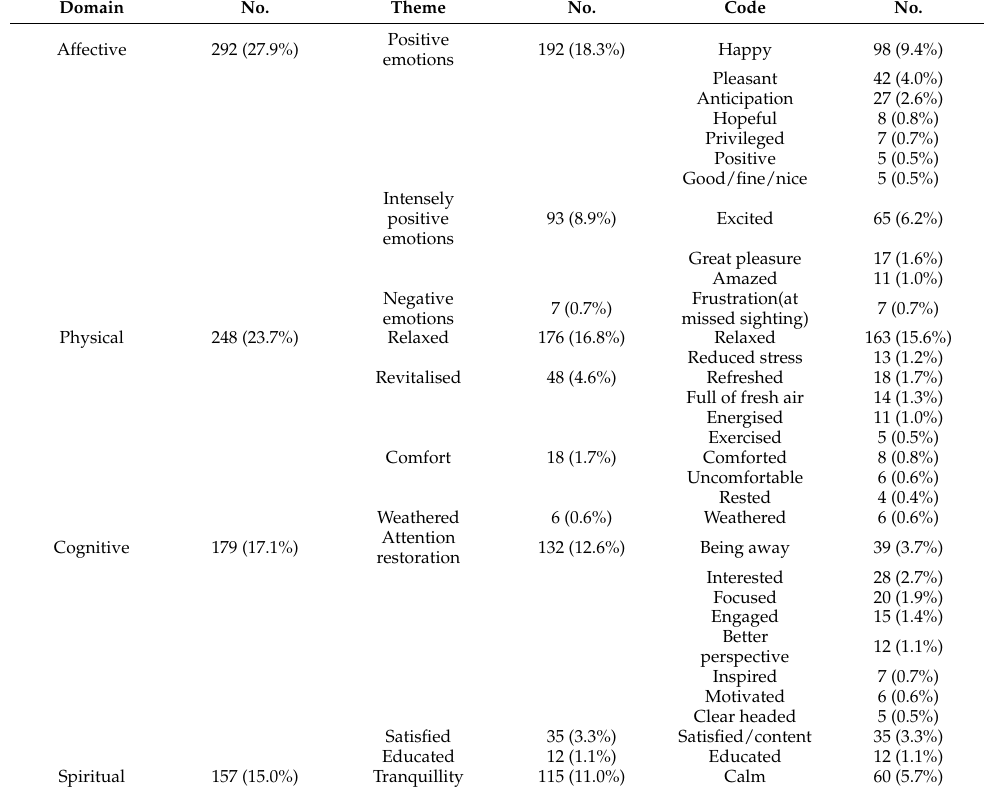
Table 2. Recalled participant-derived effects to visit UK wetland visitor centres from n = 365 partic- ipant responses to the question “Thinking about when you are at a WWT Wetland Centre, please describe how you feel during your visit” via an online survey. The number of assigned meaning units (MUs) per domain, theme or code are presented along with the percentage of total MUs for the question ( n =